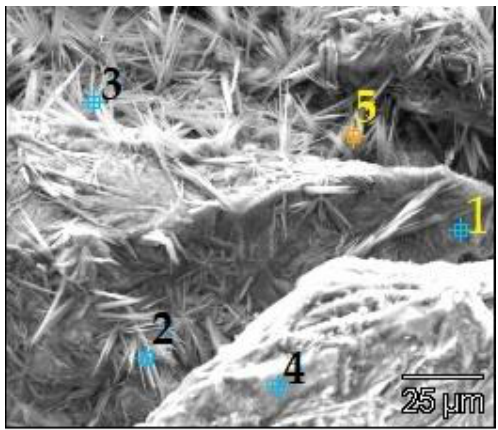
Figure 20. SEM image of “Glass Bricks”- brick modified by 90% Glass Sand, high vacuum mode.